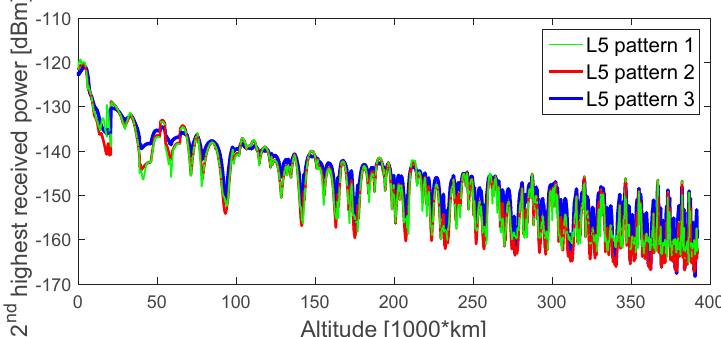
Figure 20. Second-highest received power level of GPS L5 signals, during the considered MTO, for a 0 dBi receiver gain pattern.